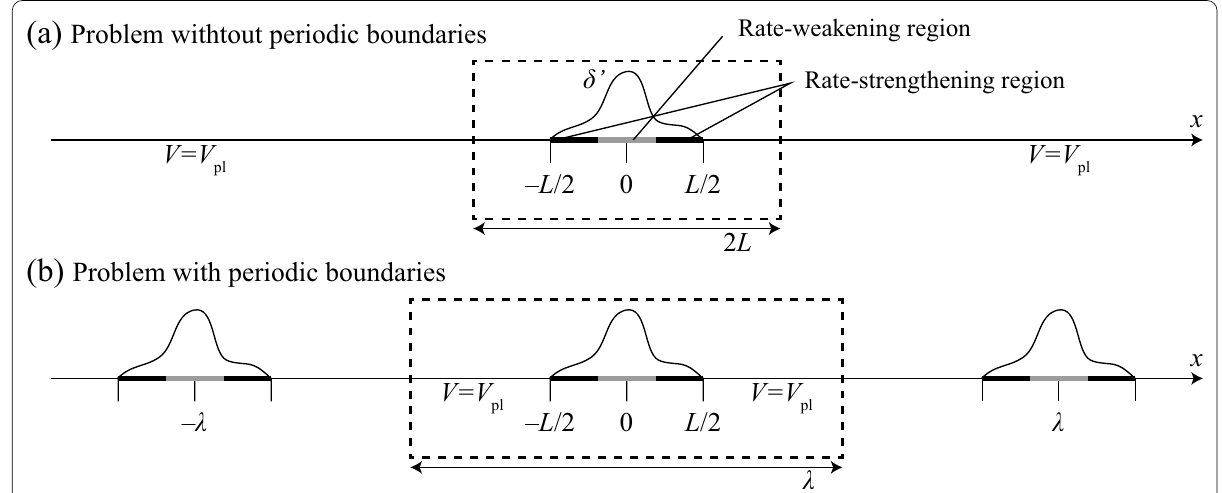
Fig. 1 a A schematic diagram of a typical problem solved with dynamic earthquake sequence simulation. A region with source of traction change (slip difference from a reference δ ′ ) distributes in a region of length L , which is governed by a rate- and state-dependent friction law. b Spectral representation and discretization with a regular mesh in the wavenumber domain causes artificial periodic boundaries every (cid:31) . Computational domains required in the present method and in the conventional method are indicated by dashed rectangles in a and b ,